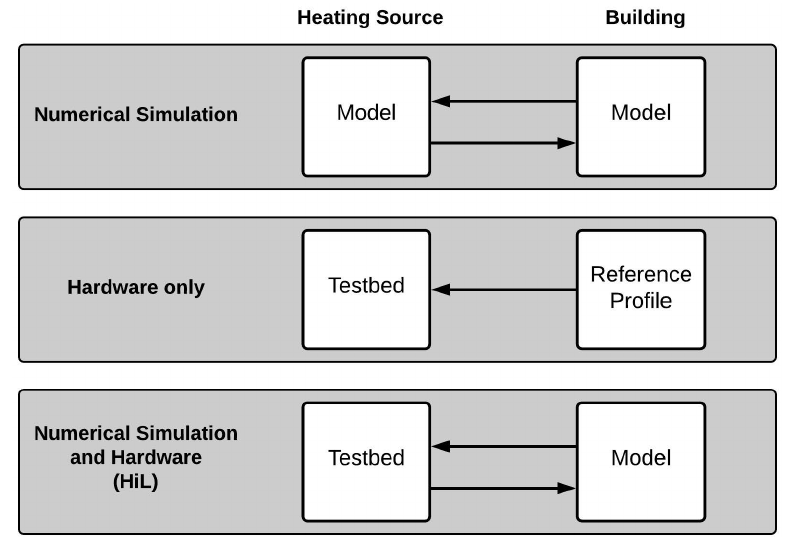
Figure 1. Abstract diagram of different methods for heating system analysis.